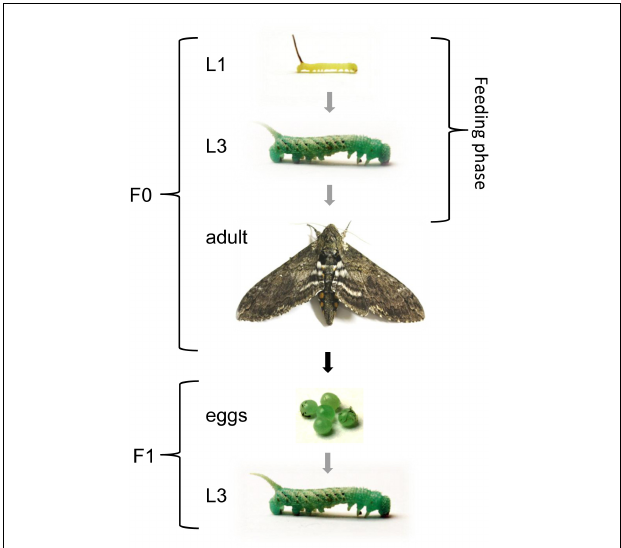
FIGURE 1 | Experimental design to investigate TGIP in M . sexta . Larvae were fed on diets supplemented with E . coli , S . entomophila or fluorescence-labeled bacteria (Bioparticles) starting at the first instar and continuing until the first sampling point at the third instar. Except for the first instar, all displayed stages correspond to sampling points. Gray arrows indicate stage progression, the black arrow indicates generational progression, and the white double arrow indicates the duration of the feeding regimes. The life cycle proceeds as follows: five larval molts, one pupal molt, one imaginal molt, (embryonic) egg